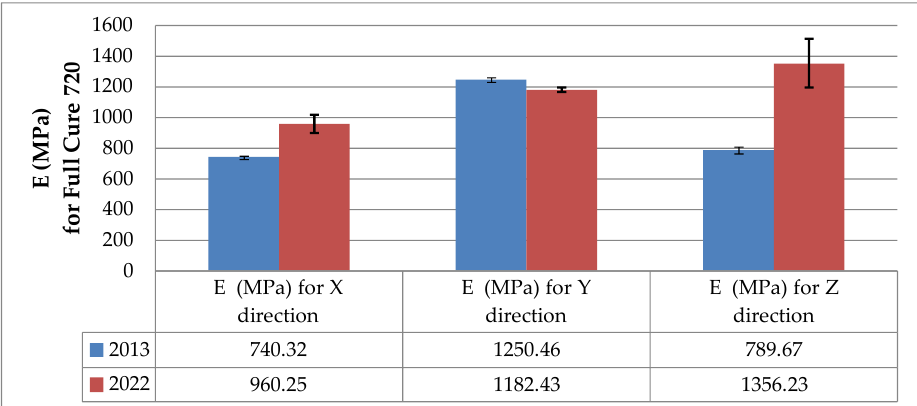
Figure 6. Modulus of elasticity E of the as-printed (December 2013) and naturally aged (July 2022) specimens based on FullCure 720 resin.